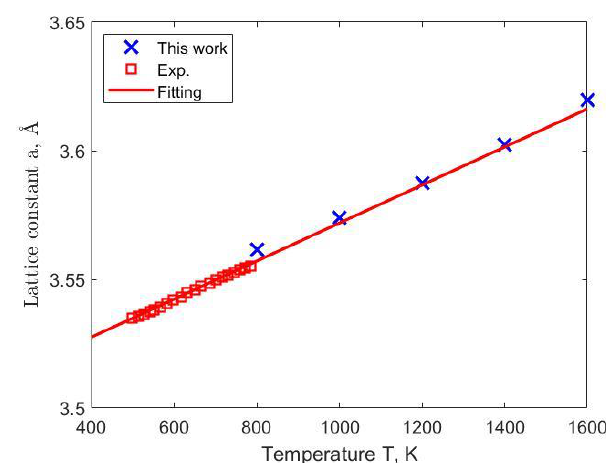
Figure 4. Lattice parameter of nickel as a function of temperature. Experimental data are from [45].